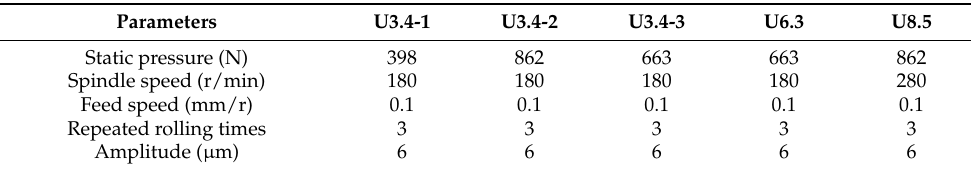
Figure 2. Fatigue source generation effect of multiple factors induced by the USRP (the colour gradient indicates the stress amplitude of the fatigue source). Table 3. Related USRP parameters of the five